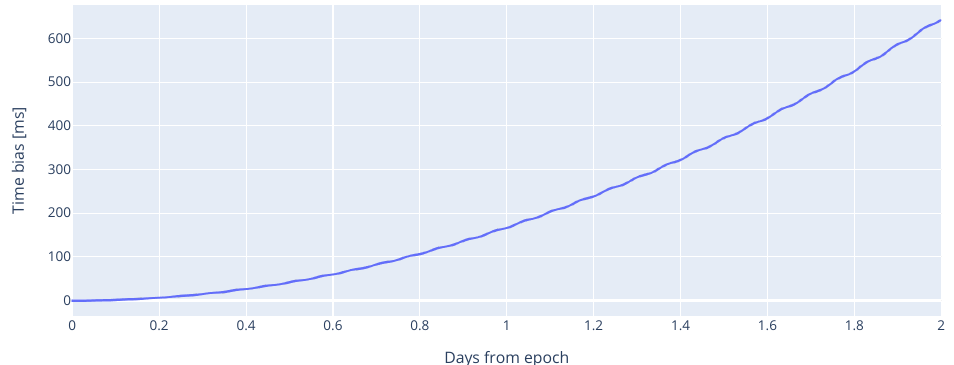
Figure 15. Simulated along-track drift between two initially identical orbits but with different pointing laws, converted to a time difference in milliseconds, as a function of the number of days since epoch. The orbit was TUBIN’s Sun-synchronous orbit at a 530km altitude. The spacecrafts were pointing nadir with each having a different offset that ensured the minimum and maximum cross-sections, respectively, with regard to atmospheric